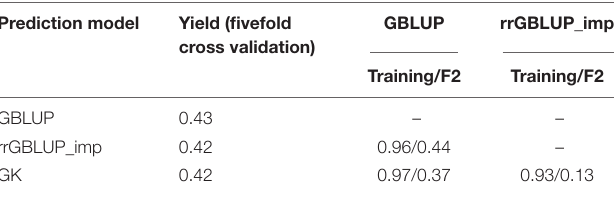
TABLE 4 | Predictive power of GEBVs in a training population of 1,334 inbreds and correlation between GEBV predictions for grain yield by three different calculation methods (GBLUP, rrGBLUP_imp, and GK) among inbreds in the training set and in a target population of 1,924 F2s. Prediction model